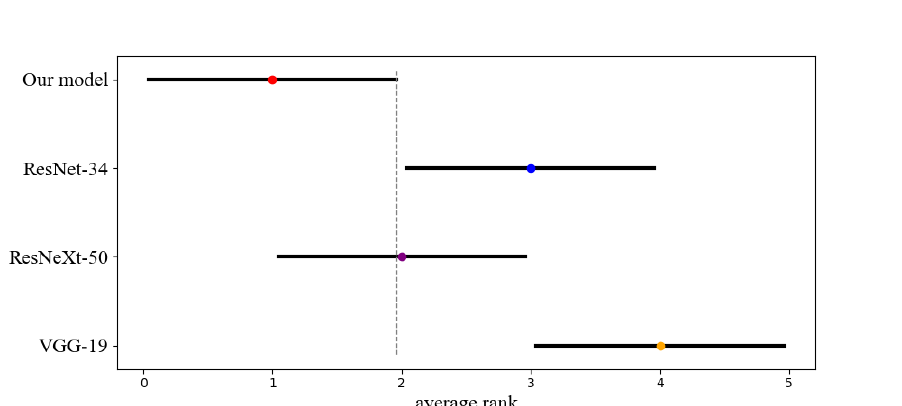
Figure 4. The difference between the average ranks of four models using the Critical Distance diagrams made from the results of the post-hoc Nemenyi test ( α = 0.05). The dot shows its average rank value, and the horizontal line with the dot at the center shows the size of its CD (1.915).